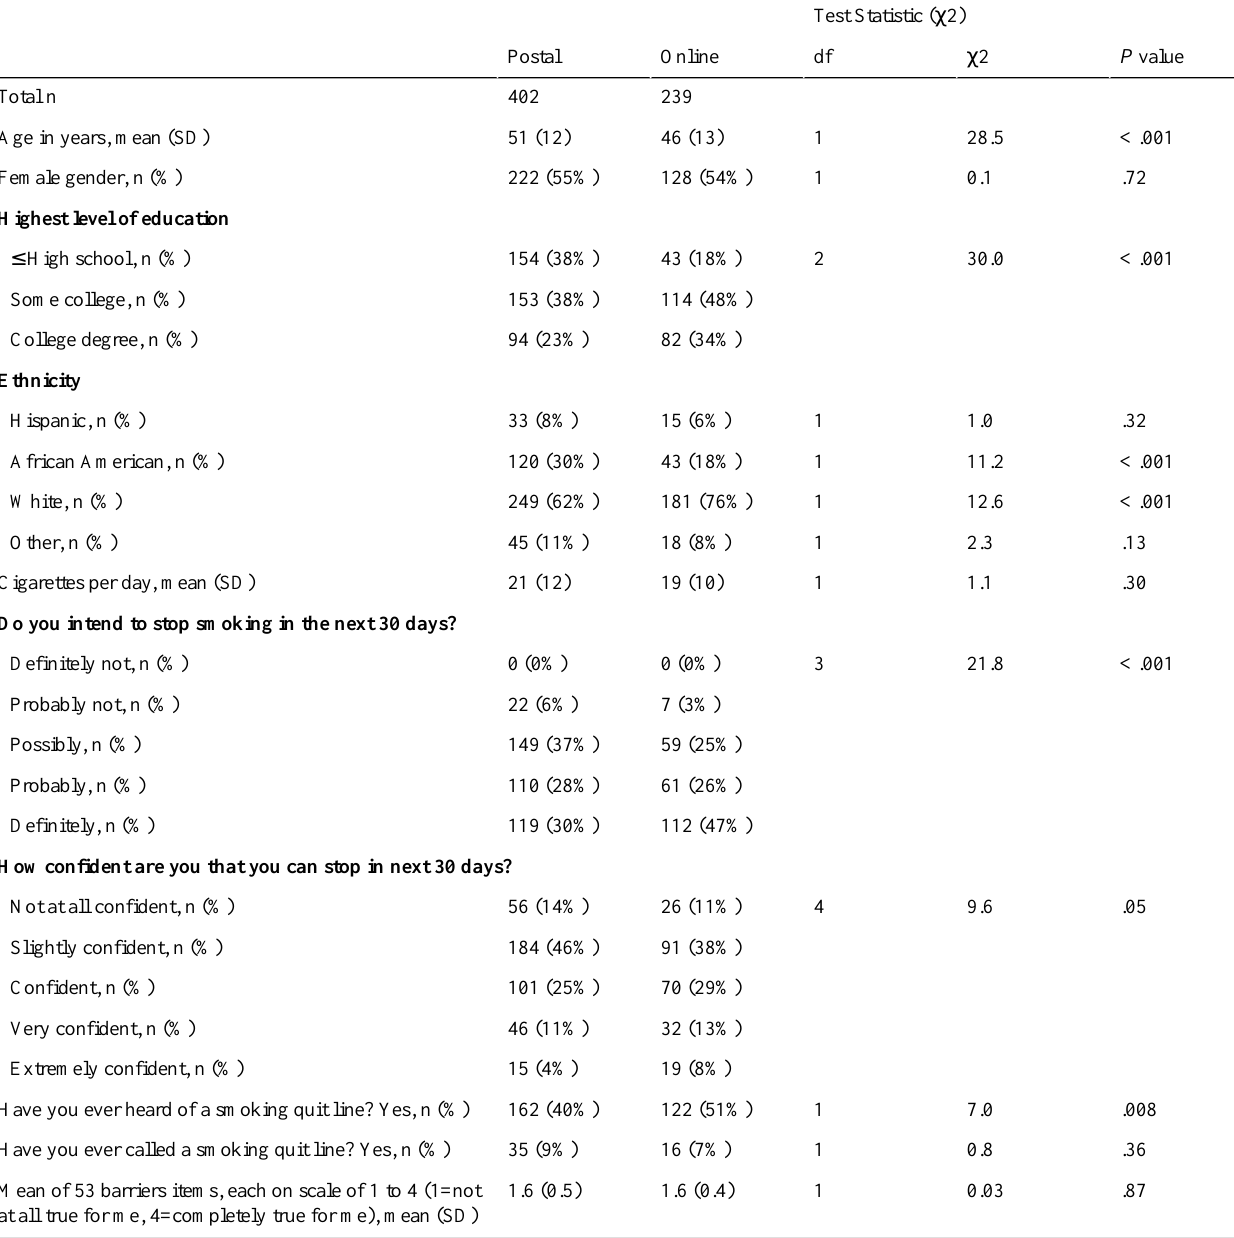
Table 1. Comparison of postal and online responses on baseline survey